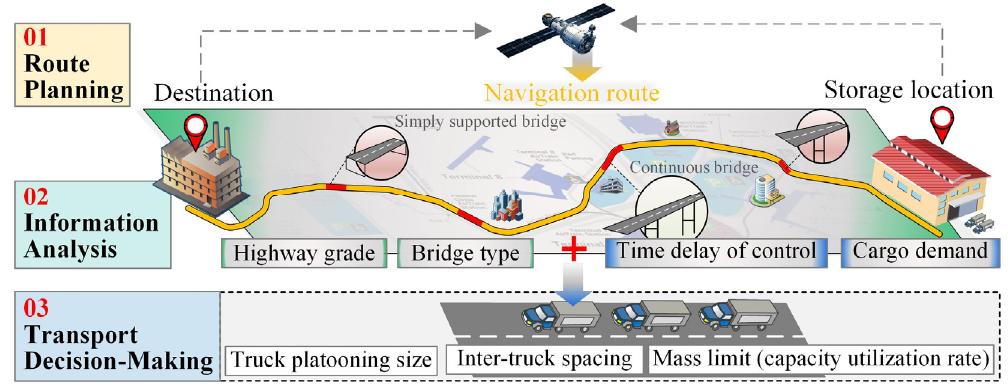
Figure 15. Loading strategy for ATP transporting cargo on a highway.